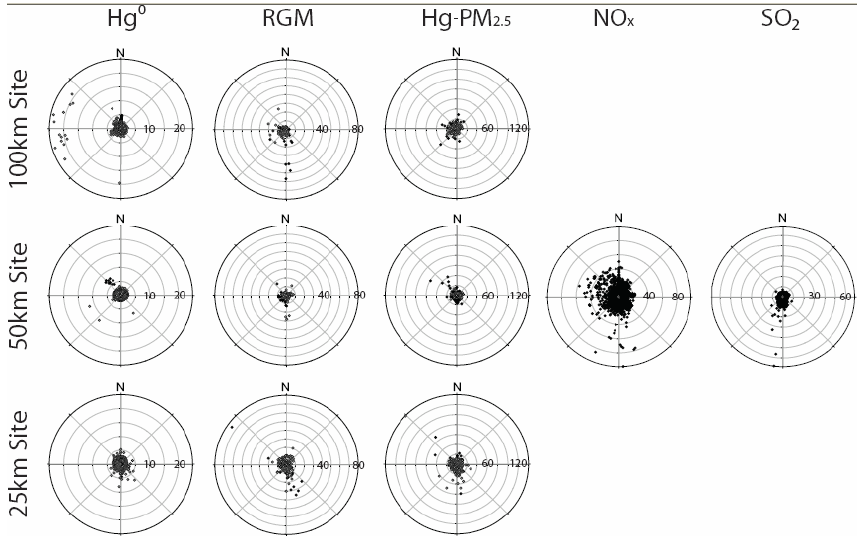
Fig. 6. Rose diagrams for mercury species (25, 50, 100km sites) and ancillary gases (50km site).